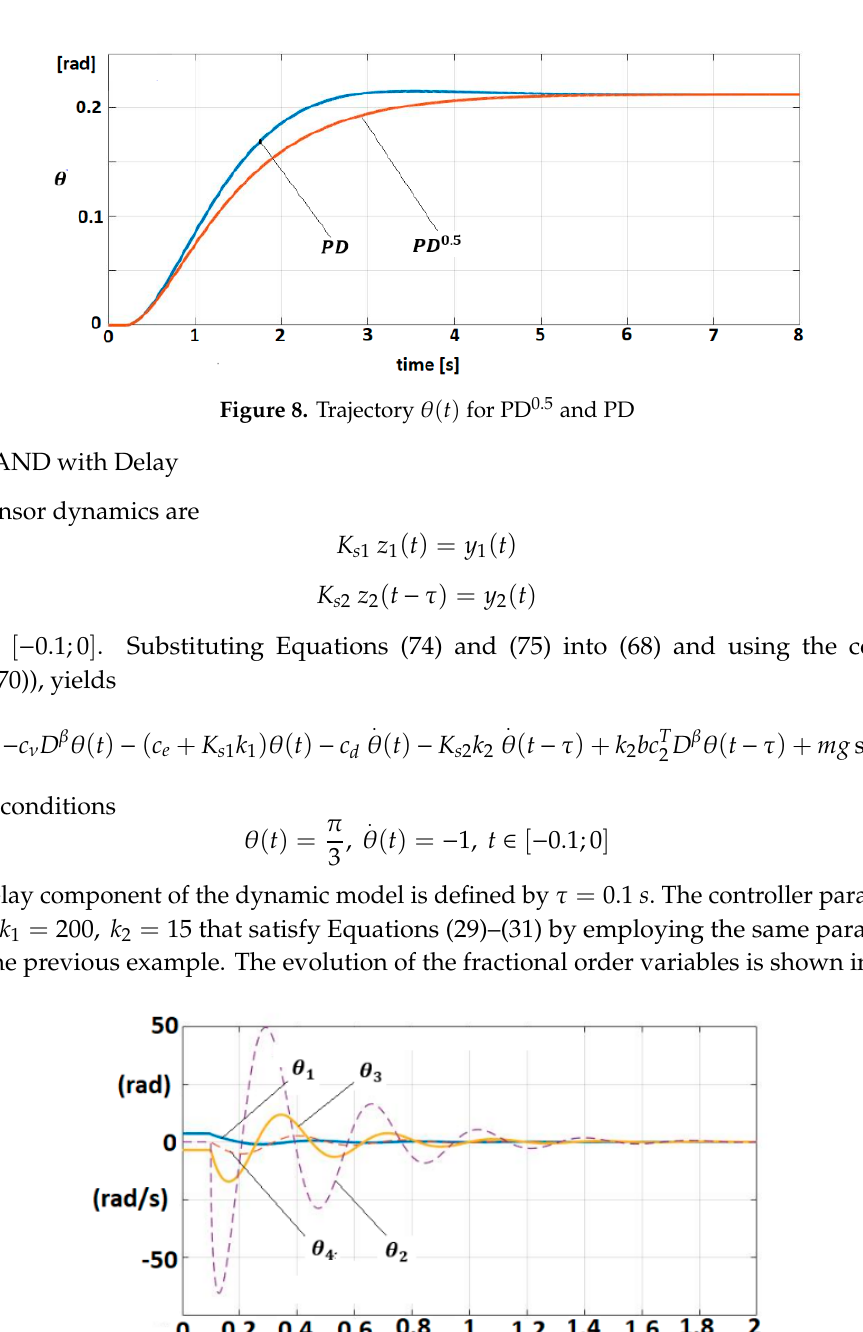
Figure 10. Trajectories of position and velocity for the system and observer. 3.2. IHRG Experimental Platform The IHRG is an exoskeleton that supports the human hand and hand activities by using a control architecture for dexterous grasping and manipulation. IHRG is a medical device that acts in parallel to a hand in order to compensate for lost function. It is easy to use and can be a helpful tool in the home [16,34]. The mechanical architecture consists of articulated serial elements of which design covers functional and anatomic finger phalanges. The glove is created by a thin textile that represents an infrastructure suitable for actuation wires and sensors. A distributed actuation system is used for implementing the operations of the hand. An Arduino Flex Sensor network (with zeroth order sensors) is used to control the motions. An Arduino Mega 2560 hardware platform determines the movement of the glove’s actuators for exercises like opening or closing of the fingers (Figures 11 and 12).